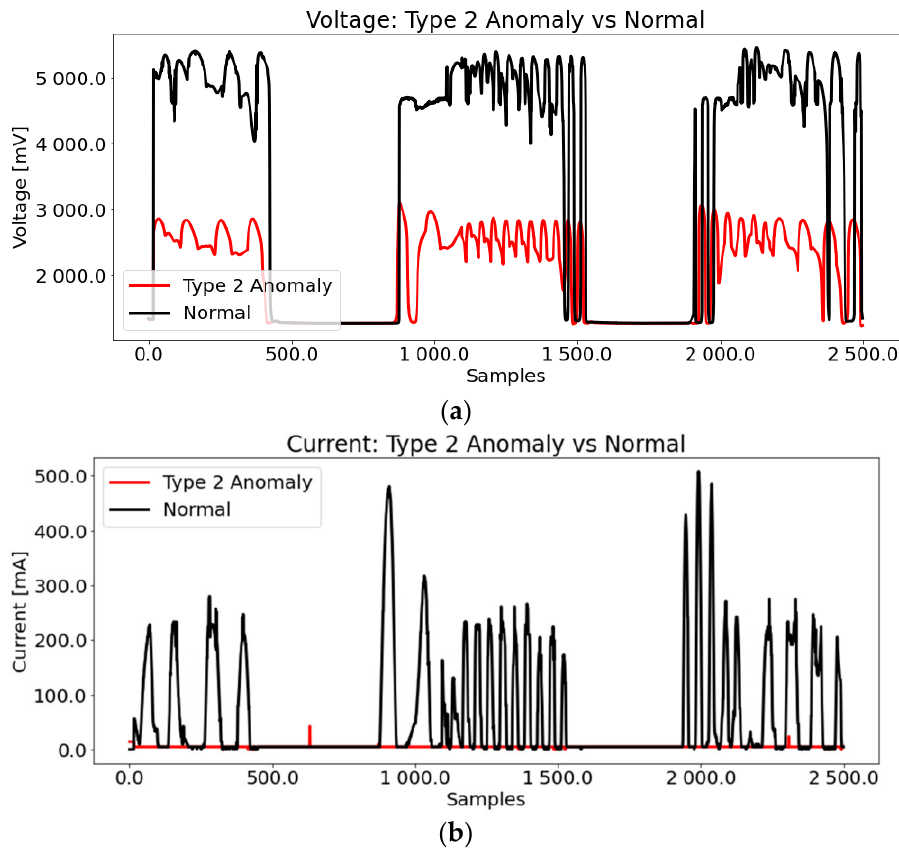
Figure 7. Type 2 anomalies in ( a ) voltage and ( b ) current data.